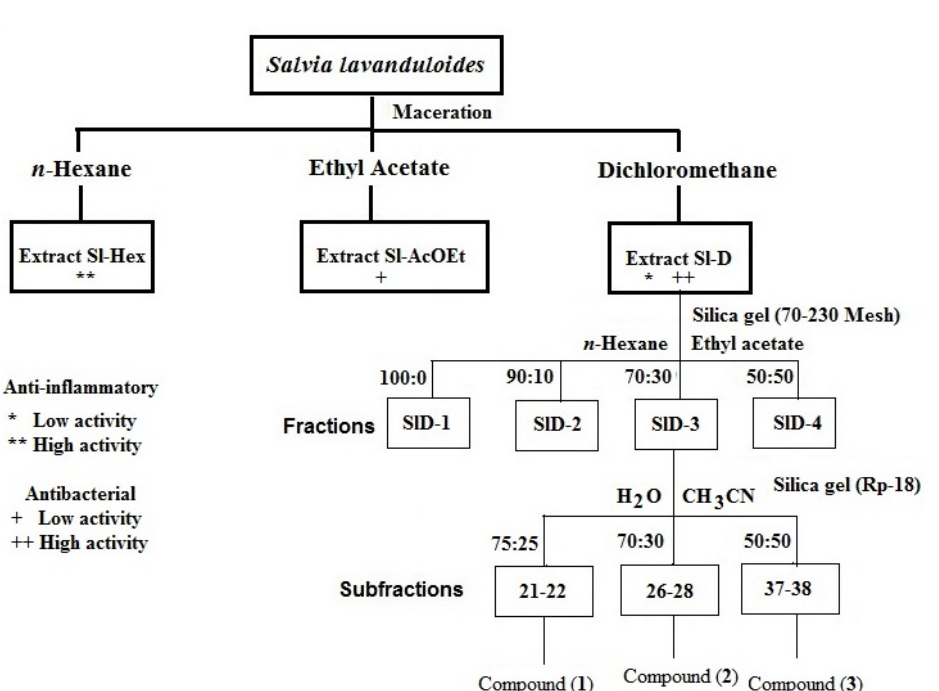
Figure 2. Protocol used to obtain all extracts, fractions, and compounds of Salvia lavanduloides . 15,16-epoxy-10- β -hydroxy-neo-cleroda-3,7,13(16),14-tetraene-17,12R:18,19-diolide ( 1 ), salviandulin A and ( 2 ) eupatorin ( 3 ).